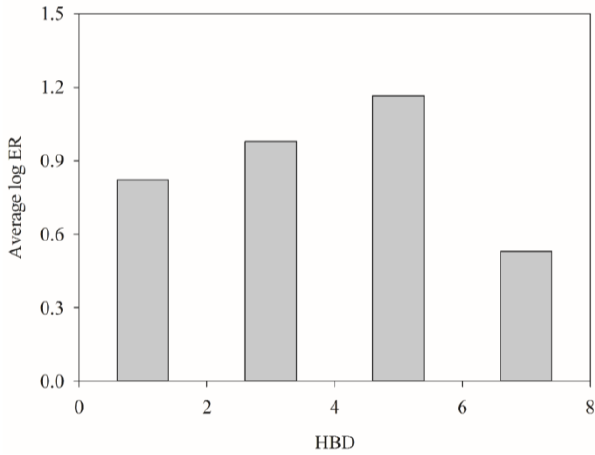
Figure 6. Average log ER vs. the distribution of HBD.